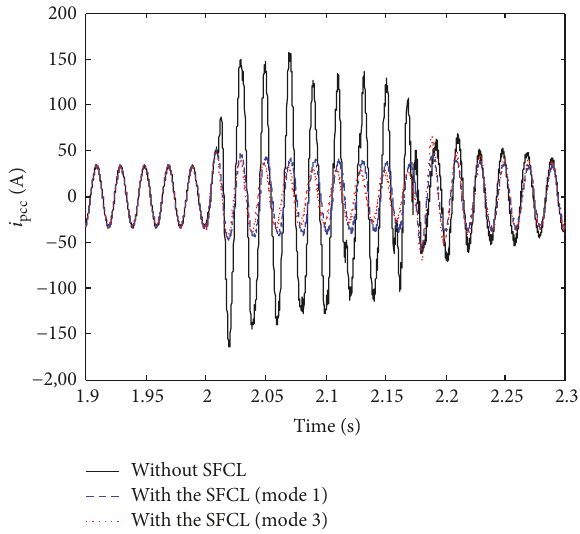
Figure 14: Behaviors of the active SFCL in limiting the PCC fault current under the symmetrical fault